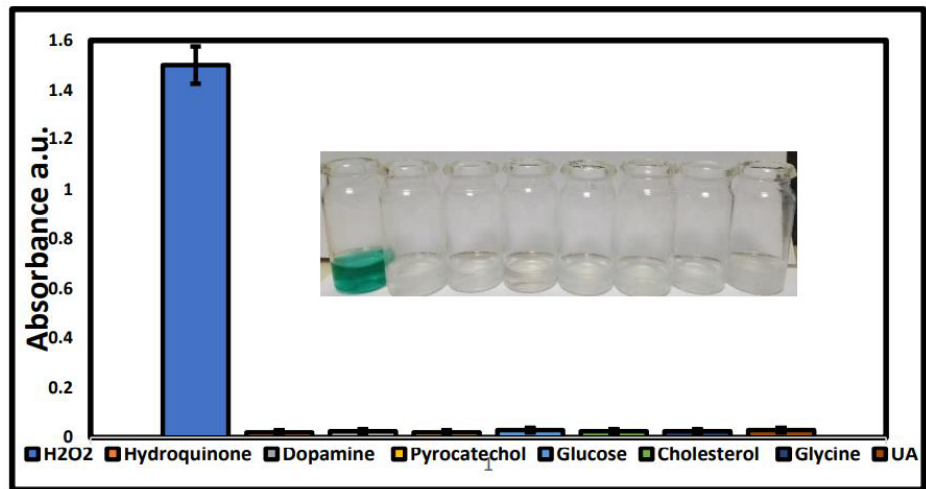
Figure 15. Absorbance response of the colorimetric sensing system in the presence of some interfering substances. The concentration and volume of all reagents were the same (250 μ M). Error bars indicate the standard deviation from three equivalent tests.